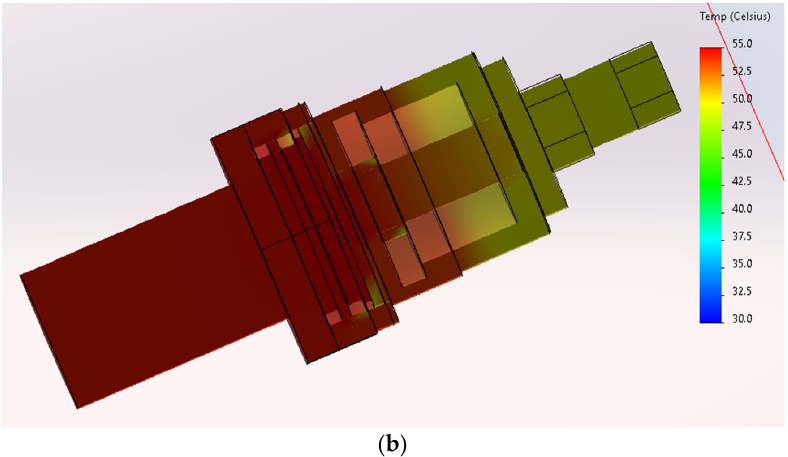
Figure 4. Temperature distribution on the case for P j = 8.17 W; ( a ) temperature distribution on the external surface of the case, ( b ) temperature distribution on the internal surfaces of the case.